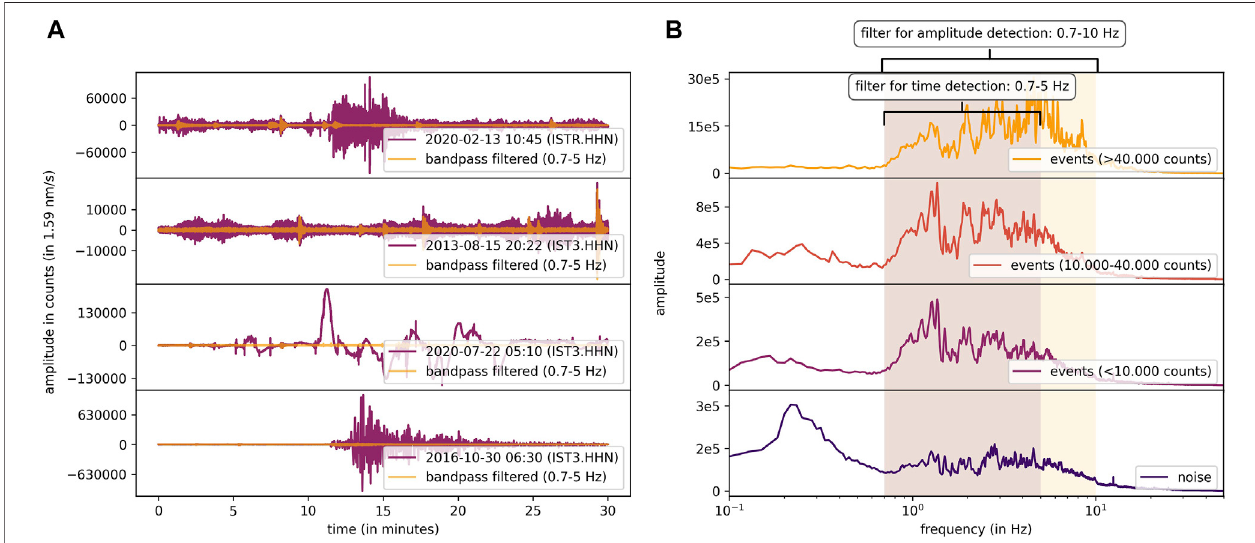
FIGURE 3| (A) Local disturbances at Stromboli. Their source is partly unknown. Because they can completelyobscureseismo-volcanic events, aband-pass fi lter (0.7 – 5 Hz) is applied, which is effective in removing the disturbances in most cases. (B) Spectra of seismo-volcanic events with different signal amplitudes and noise levels(averagedspectrafor100signalseach).Theintensityofnoiseislargestforfrequenciesnear0.2 Hz,probablyduetooceanmicroseisms(Ardhuinetal.,2011).The main frequency range for explosive events is between 0.7 and 10 Hz.